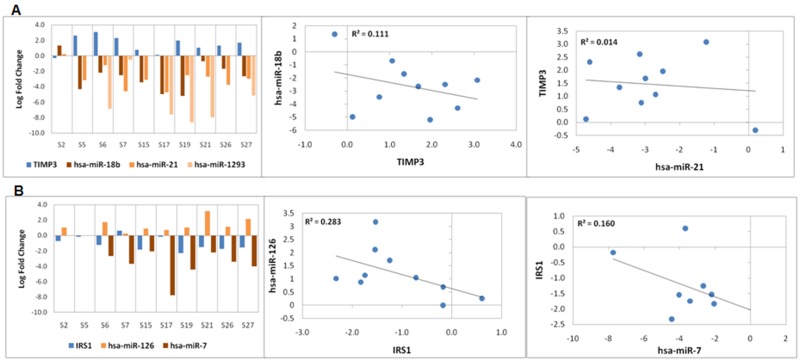
Expression deregulation of miRNA and target mRNAs.(A) Bar plots show log2fold change in expression of miRNAs (hsa-miR-18b, hsa-miR-1293and hsa-miR-21) and their target, TIMP3. Scatter plots show negative correlation of TIMP3 expression with hsa-miR-18b and hsa-miR-21expression. Negative correlation was not observed between TIMP3 and hsa-miR-1293. Negative values of log2fold change indicate upregulated expression whereas positive log2fold change values indicate downregulation. (B) Bar plot showslog2fold change of expression of miRNAs (hsa-miR-126 and hsa-miR-7) and their target, IRS1. Scatter plot shows negative correlation of IRS1 expression with hsa-miR-126 and hsa-miR-7expression. Negative values of log2fold change indicate upregulated expression whereas positive fold change values indicate downregulation.